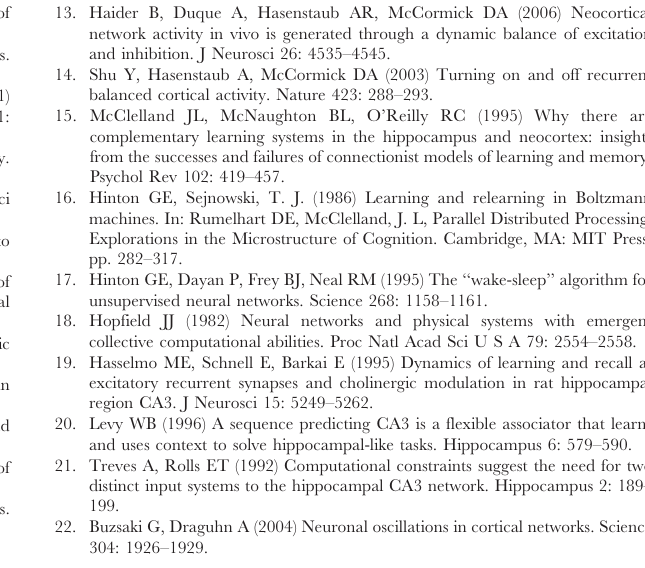
Table S1 Parameter insensitivity. Operational ranges that maintain accuracy above 0.80 on the single triangular wave input pattern (Fig. 2). Spike-rate memory and potentiation memory are the widths of averaging time window for calculating mean spike- rate and mean potentiation, respectively. Asterisks denote conservative bounds because values beyond were not